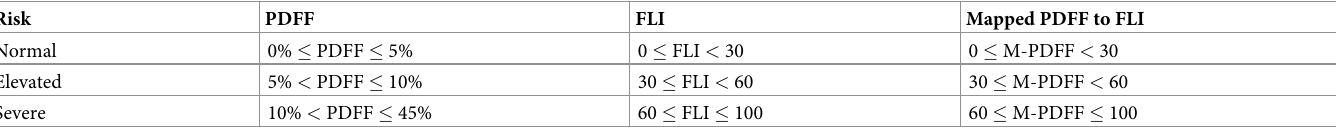
Table 1. MRI derived PDFF risk range mapped to equivalent FLI risk range.